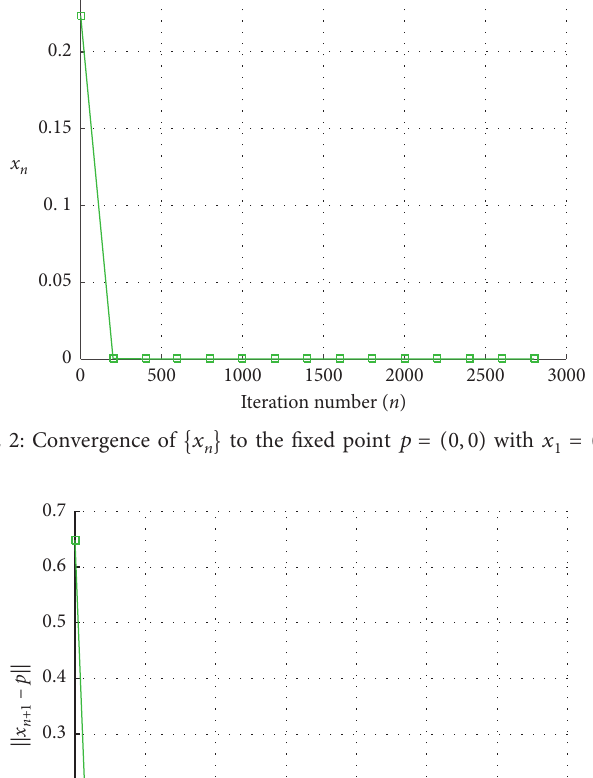
− p ‖ as x 􏼈 􏼉 converges to the fixed point p � (− 1 , 1 ) with x n + 1 n